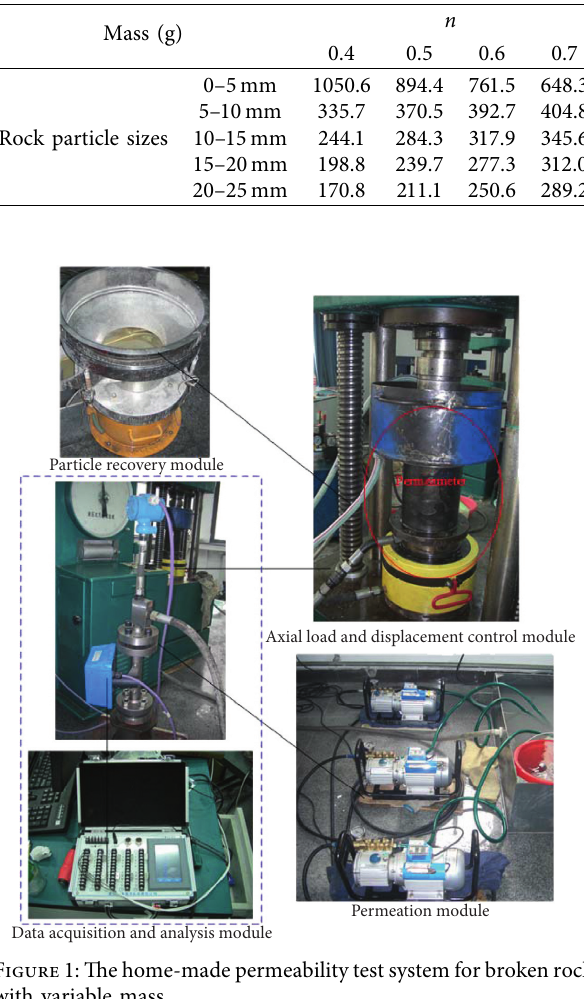
Figure 1: The home-made permeability test system for broken rock with variable mass.